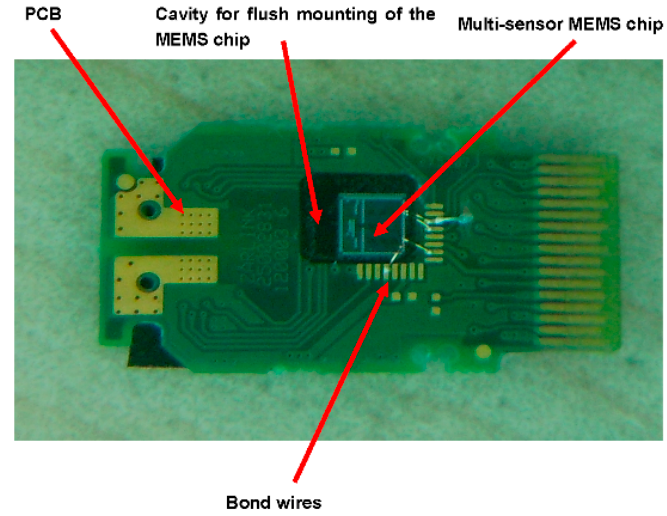
Figure 8. Multi-sensor MEMS chip bonded on a PCB. A cavity was carved in the PCB to accommodate the MEMS chip. The rest of the cavity was filled up with a UV-cured adhesive that ensured stress-free sealing of the chip and the pressure sensor.